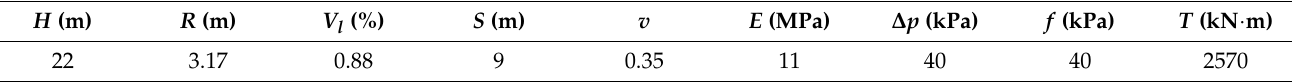
Table 1. Input parameters for displacement calculation.